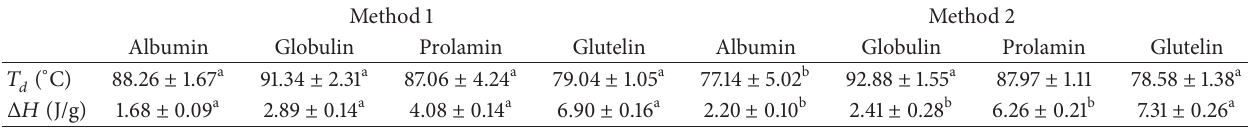
Table 4: DSC analysis on the denaturation of FRBPs prepared by the two extraction methods.